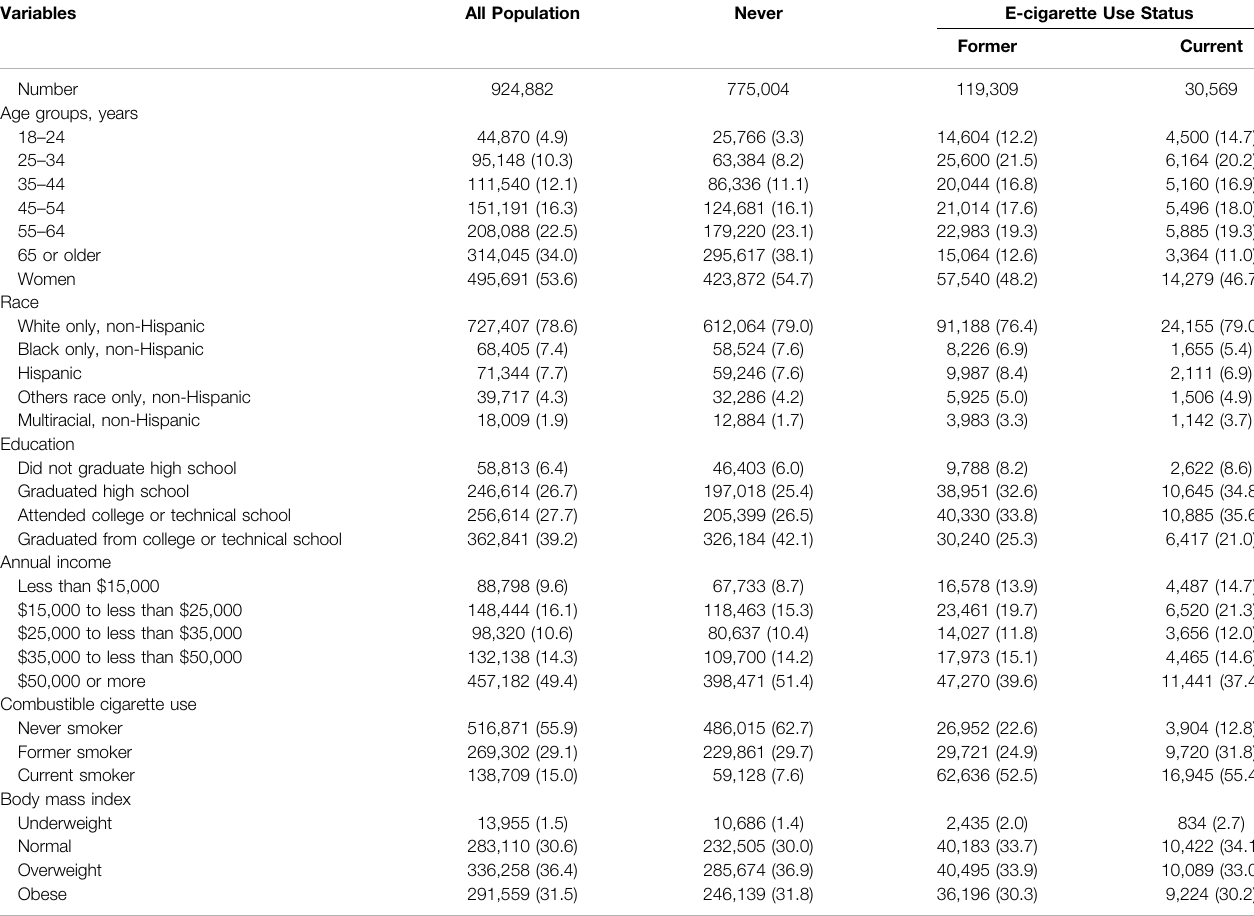
TABLE 1 | Characteristics of the study participants according to e-cigarette use, BRFSS 2016 to